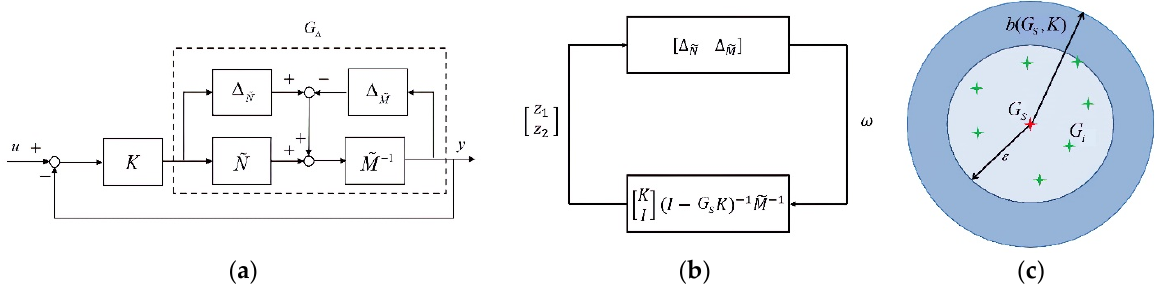
Figure 3. System perturbations and stability analyses: ( a ) The closed-loop system; ( b ) System rearrangement; ( c ) The philosophy of robust control.